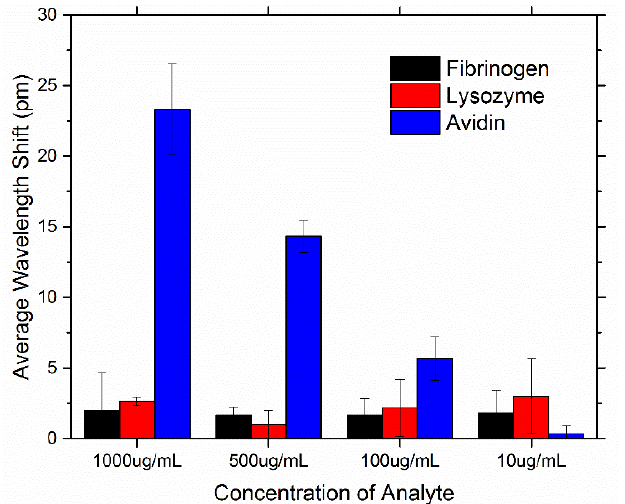
Figure 13. Average resonant wavelength shift of the PEG-biotin:PEG coated microresonators at concentrations of 1000, 500, 100, and 10 μ g/mL for fibrinogen, lysozyme, and